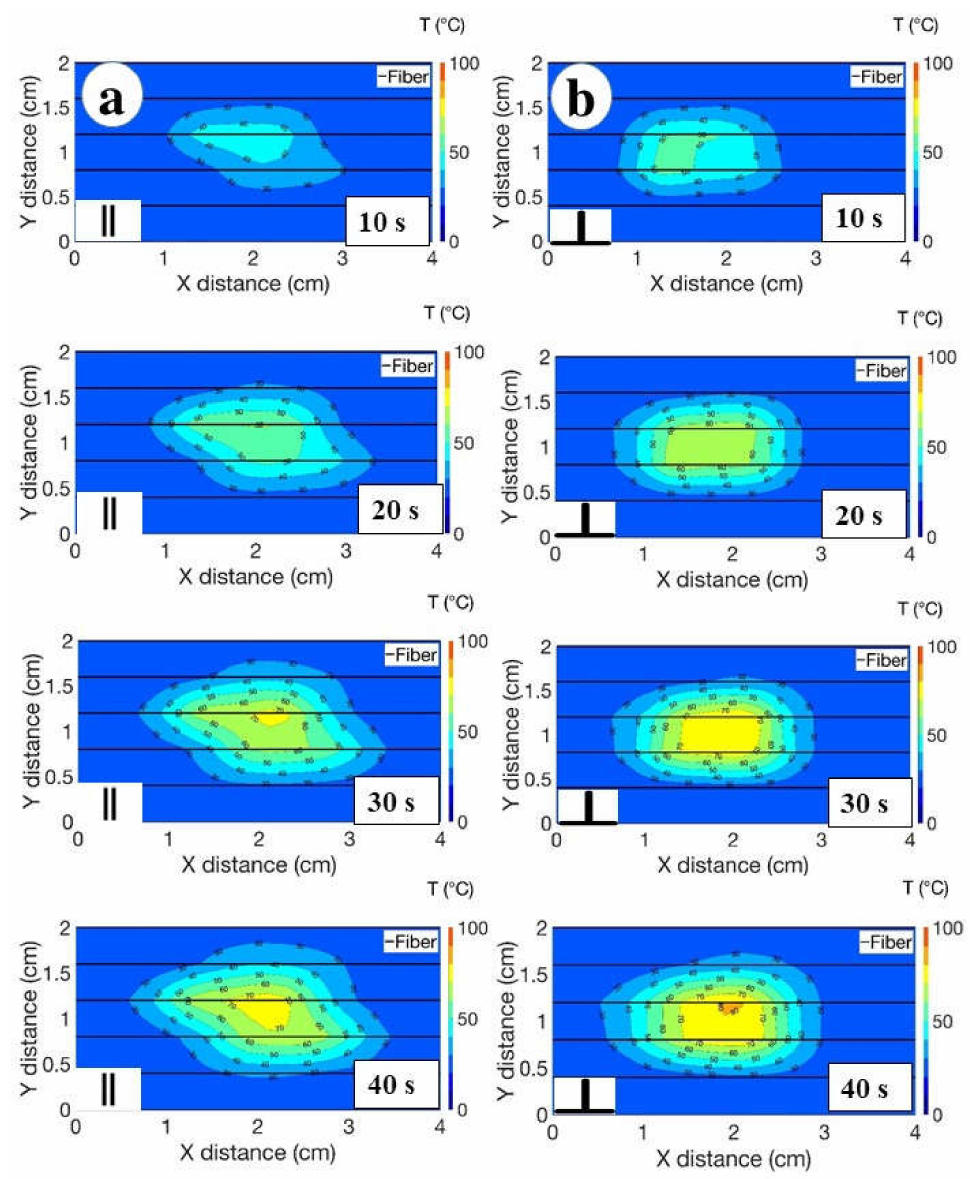
Figure 7. The cinematic view recorded during the RFA of the liver tissue injected with agarose over 40 s for two heating scenarios: ( a ) the parallel location of the blood vessel and optical fibers; ( b ) the perpendicular location of the blood vessel and optical fibers. The thermal map was registered every 10 s. Different colors on the 2D map stand for the different temperature values. The two dimensions illustrate the fiber location parallel to the x plane. The maximum temperature was recorded at 40 s of the ablation. The charts report the isothermal curves, sampled at each 10 ◦ C temperature